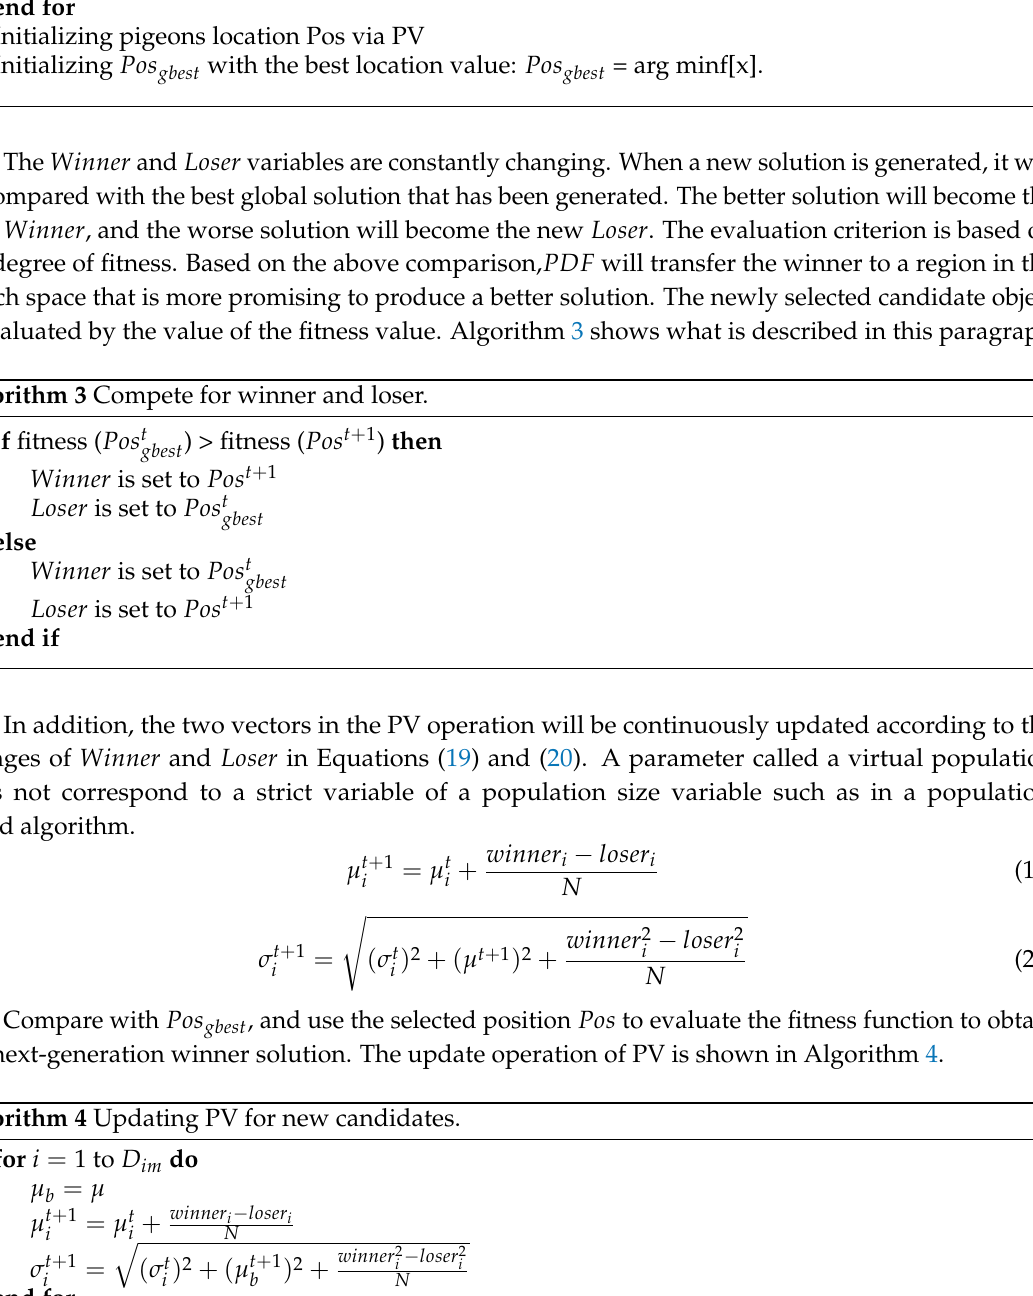
Algorithm 5 represents the pseudo code of the steps of the compact PIO. Sampling by probability represented in its